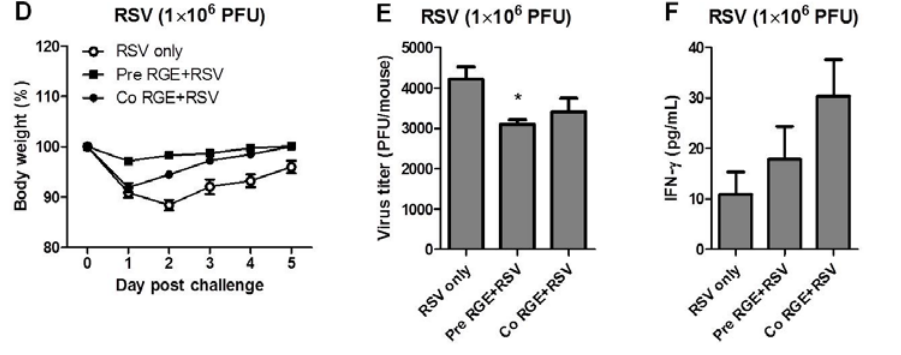
Figure 5. Pretreatment with red ginseng extract (RGE) improves clinical outcomes in mice upon infection with respiratory syncytial virus (RSV). Changes in body weight ( A , D ), lung viral titers ( B , E ), and bronchoalveolar lavage fluids (BALF) cytokine level of interferon (IFN)-γ ( C , F ) were determined at day 5 post RSV infection. Values are the mean ± SEM. * p < 0.05; ** p <0.01; *** p < 0.001 vs. RSV-infected control. RSV only: naïve mice infected with RSV in PBS, Pre RGE + RSV: naïve mice were pretreated intranasally once with RGE (4 mg per mouse) 24 h prior to infection with RSV, Co RGE + RSV: naive mice were treated once intranasally with a mixture of RGE (4 mg per mouse) and